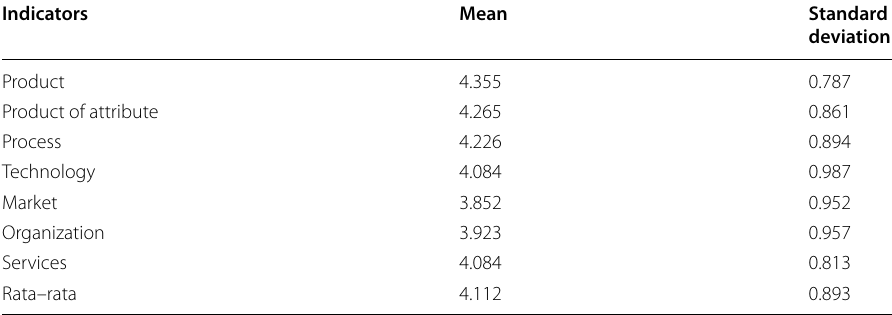
Table 5 Mean score for implementation cloning